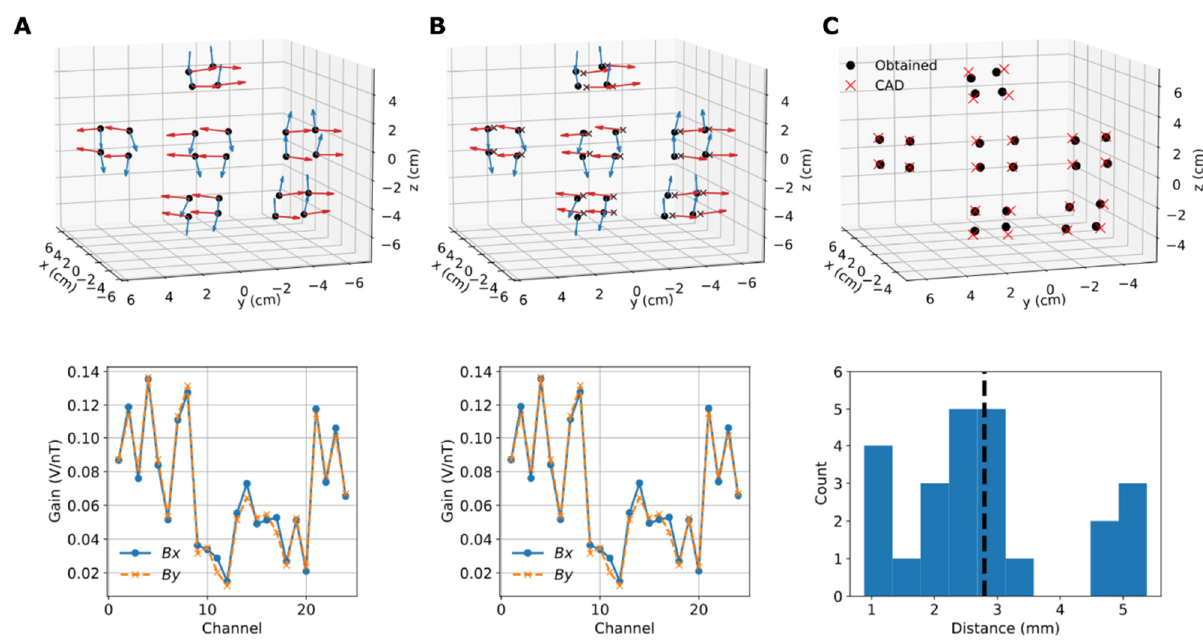
Figure 5. Obtained OPM sensor parameters: ( A ) Sensor parameters (top: position, orientation; bottom: gain) obtained by joint optimization, i.e., assuming that the channels sensing either of the tangential field components ( Bx or By ) share the same location. The blue and red arrows correspond to Bx and By , respectively. ( B ) Sensor parameters obtained by treating the channels separately, i.e., the Bx and By channels have independent locations. The channel positions for Bx and By are shown as black dots and crosses, respectively. ( C ) Comparison of the sensor positions in panel A to the CAD model of the sensor array. Histogram illustrates the distances between the positions; vertical dashed line shows the average distance.